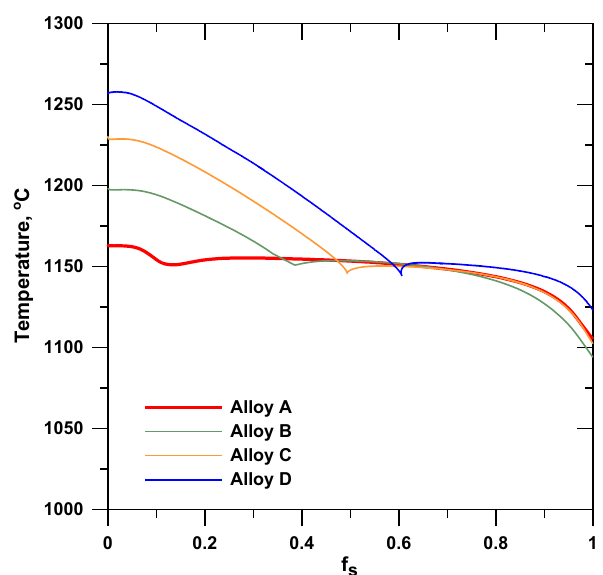
Figure 4. Solid fraction variation with temperature.